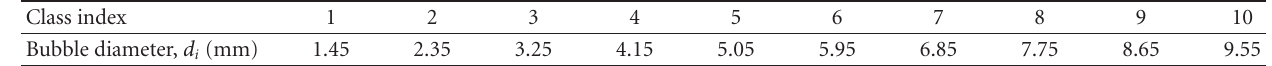
Table 1: Diameter of each bubble class tracked in the simulation.